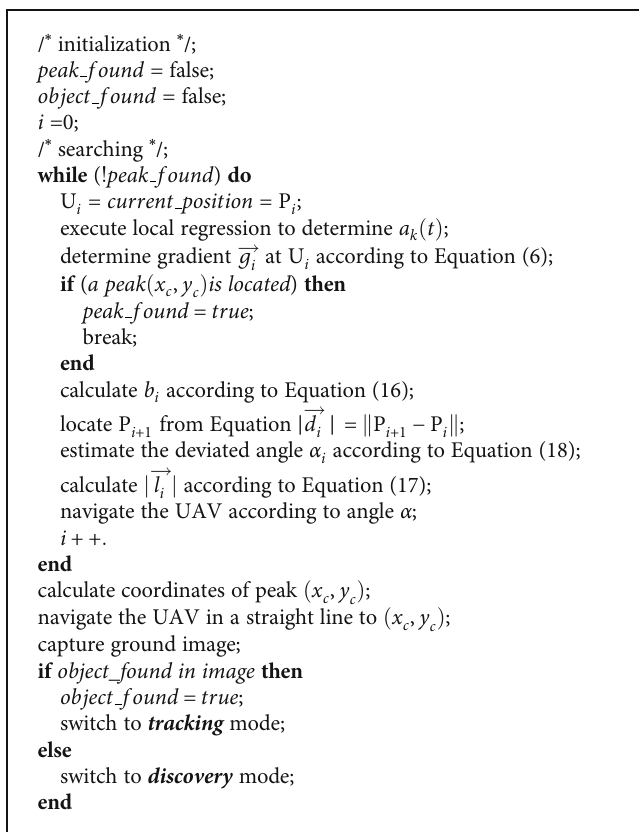
Algorithm 1: Monitoring a moving object: from searching to